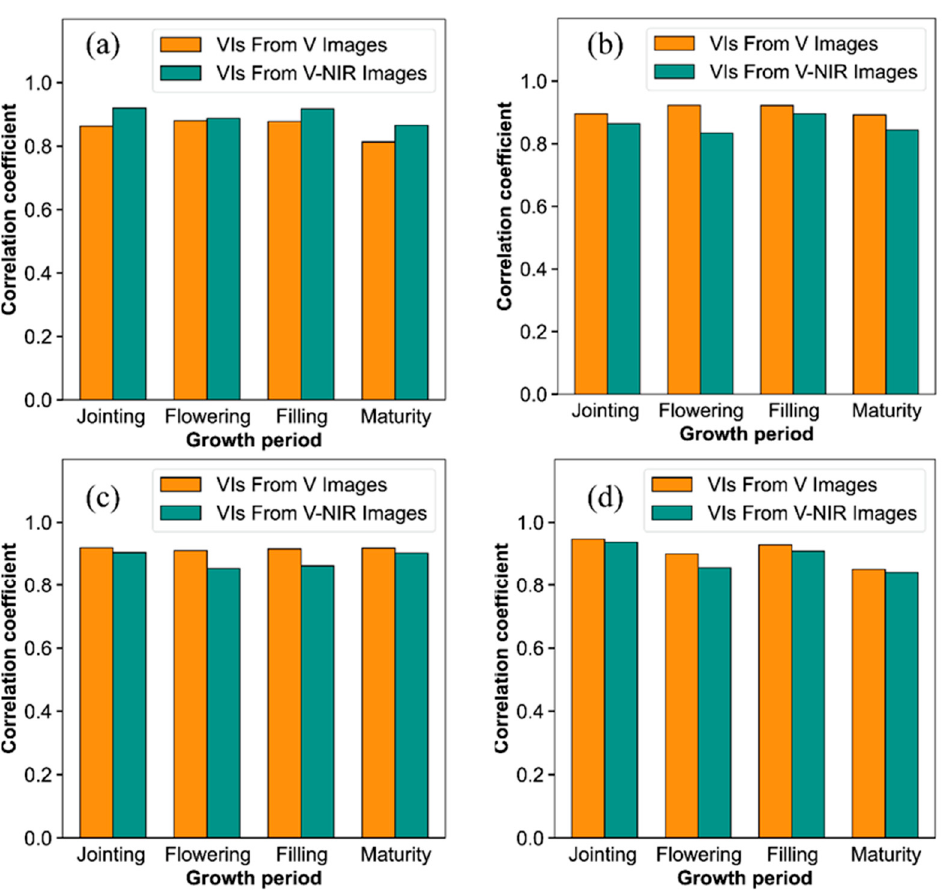
Figure 5. Comparison of validation results of RF models used for estimating ( a ) PH, ( b ) AGB, ( c ) LAI, and ( d ) NNI using V images and V-NIR images at different growth periods.